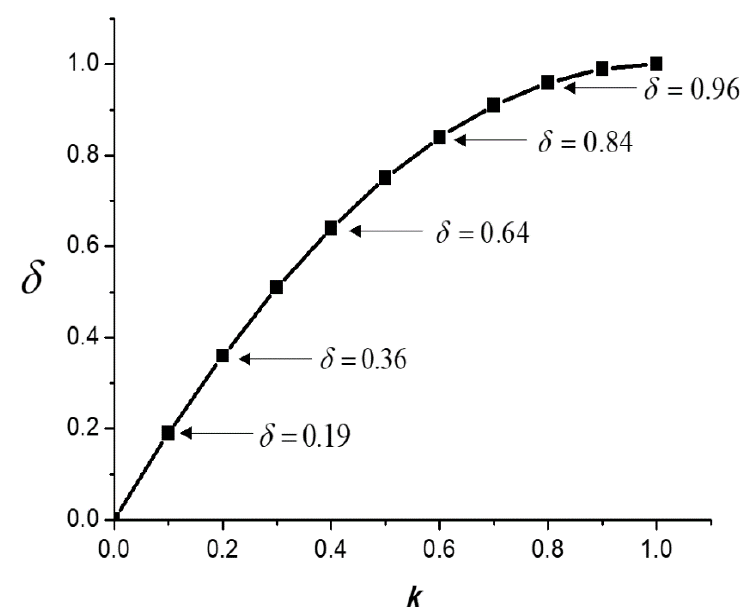
Figure 4. Relation of k and δ .